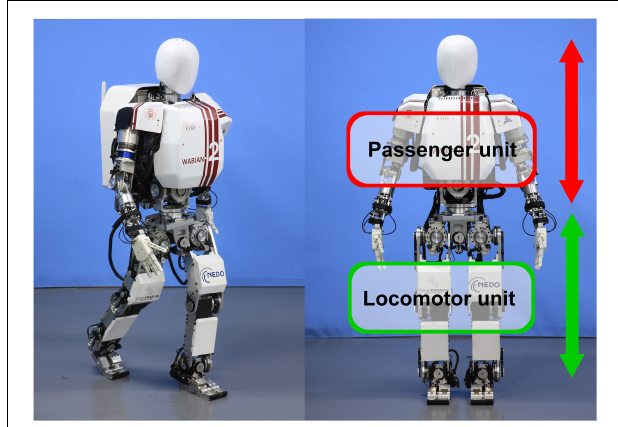
FIGURE 2 | The humanoid robot WABIAN-2R. It is capable of human-like walking with its stretched knees and pelvis